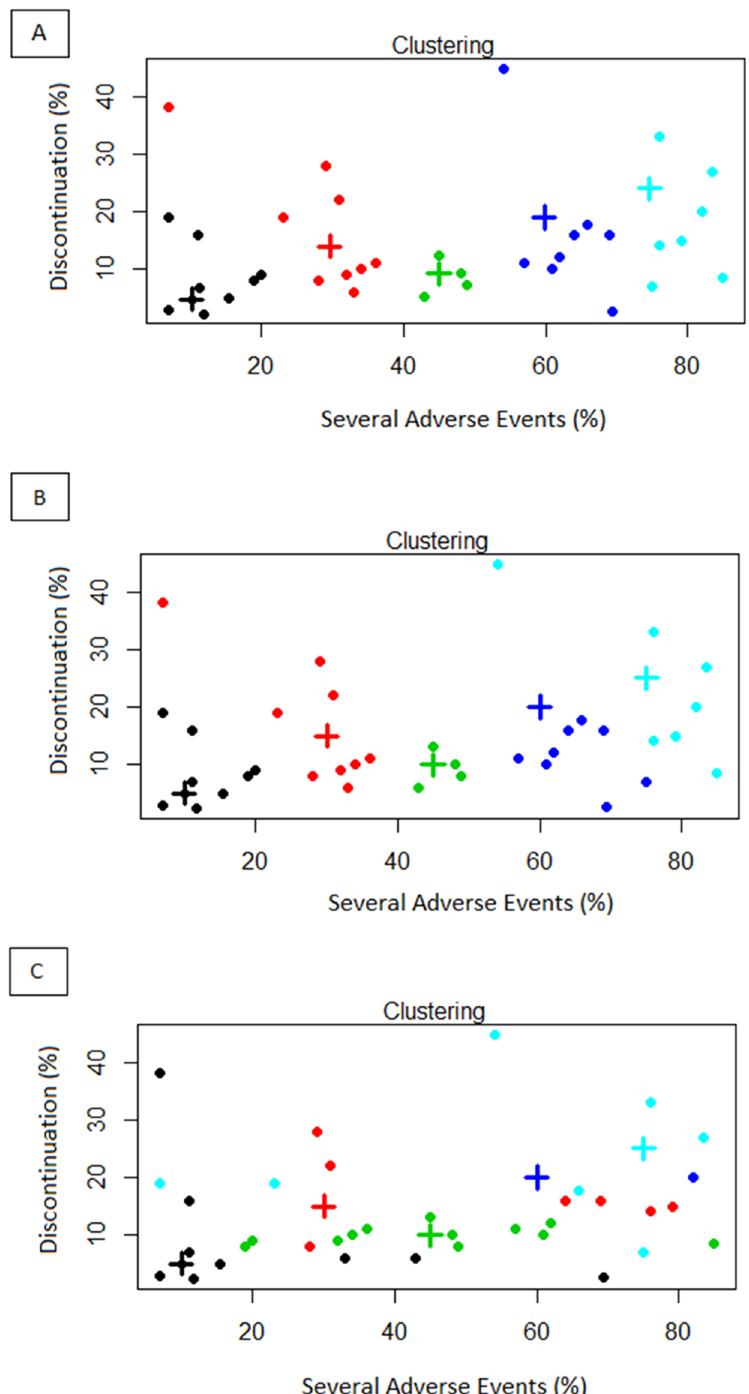
Fig 2. Cluster analysisbasedon Toxicity Index (TI) consideringEuclidean distance(A), maximum distance (B) and minimum distance(C). The “+” represent the centroids.